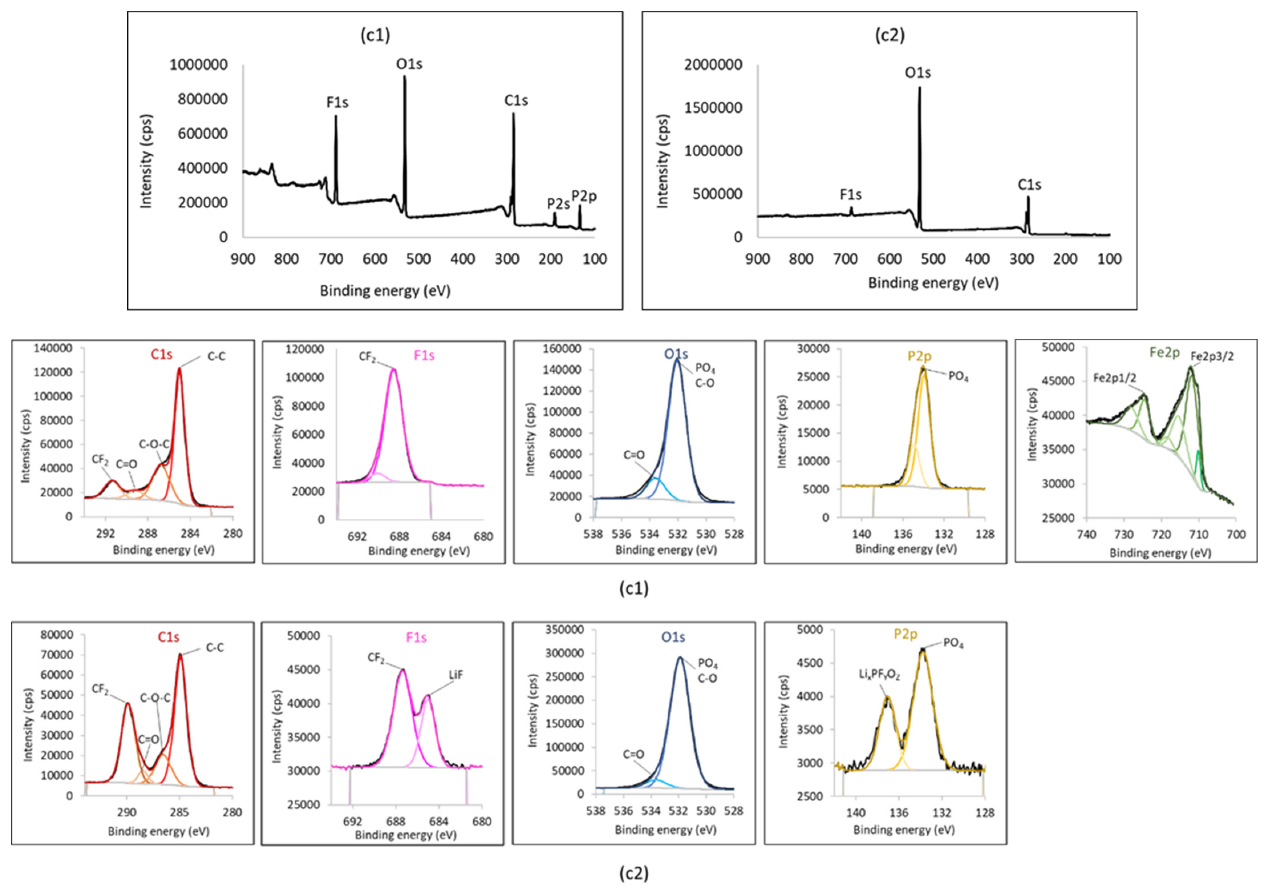
Figure 5. XPS spectra of the LFP cathode coating with Kynar PowerFlex ® LBG binder: ( c1 ) as prepared and ( c2 ) postmortem after 25 battery cell cycles.